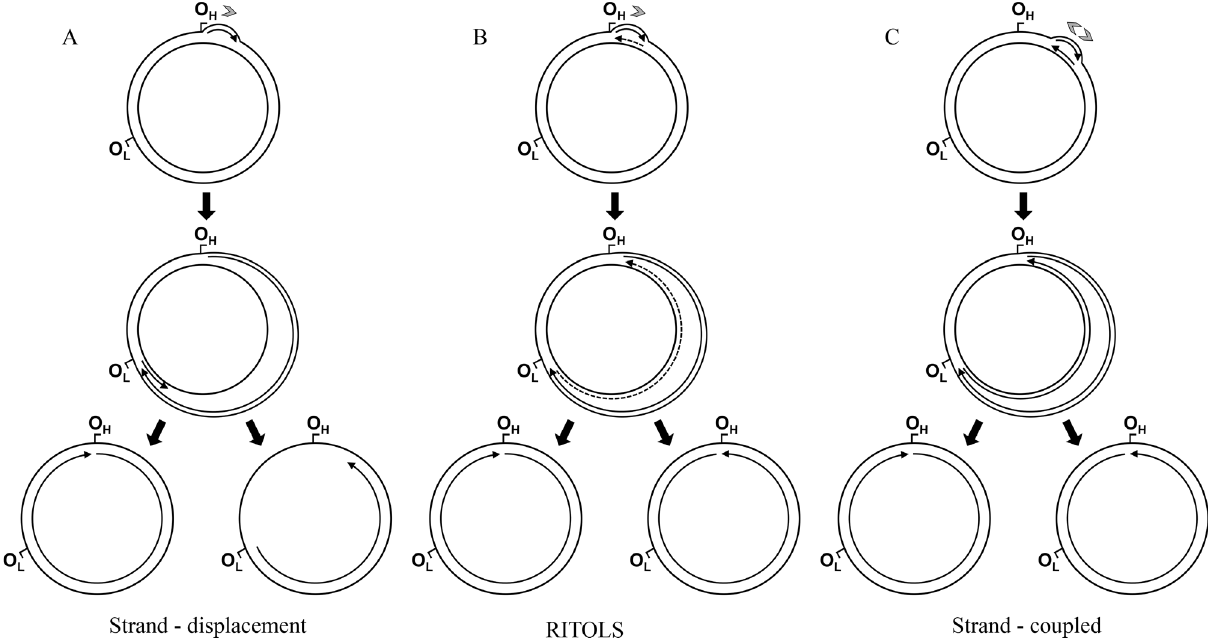
Figure 2 - Current models of mammalian mtDNA replication: the strand-displacement (A), the RNA incorporated throughout the lagging strand - RITOLS(B),andtheleadingandlaggingstrand-coupled(C)models(seetextfordetaileddescriptionofthemodels).Inallmodels,thesitesO H andO L are represented as reference points to the genome map (Figure 1), although these sites are primarily important for the strand-displacement model. Arrows as- sociated with replicating mtDNA indicate the 5’ to 3’ direction of nucleic acid synthesis; continuous and dashed lines represent DNA and RNA, respec- tively (only the long stretches of RNA described in the RITOLS model are represented; the possible short RNA primers of the other models are not shown). Gray arrowheads indicate the number and directionality of replication forks generated at the origin, according to each